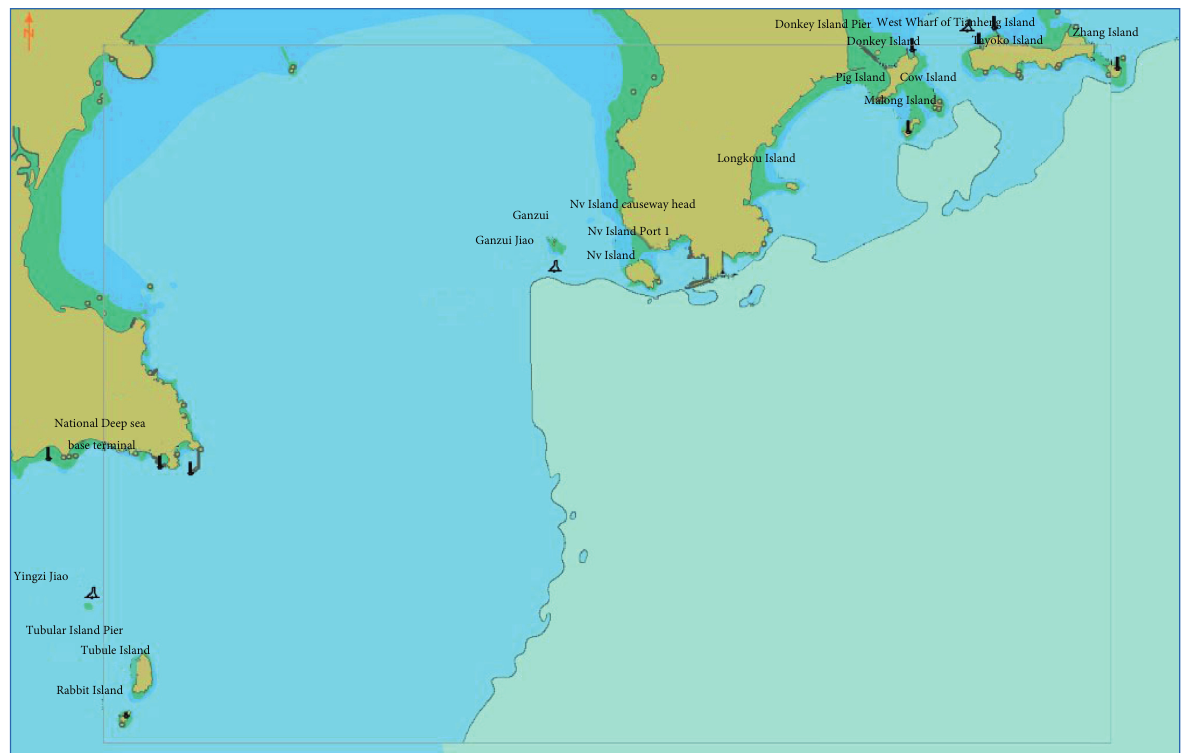
Figure 20: Electronic chart simulation environment.